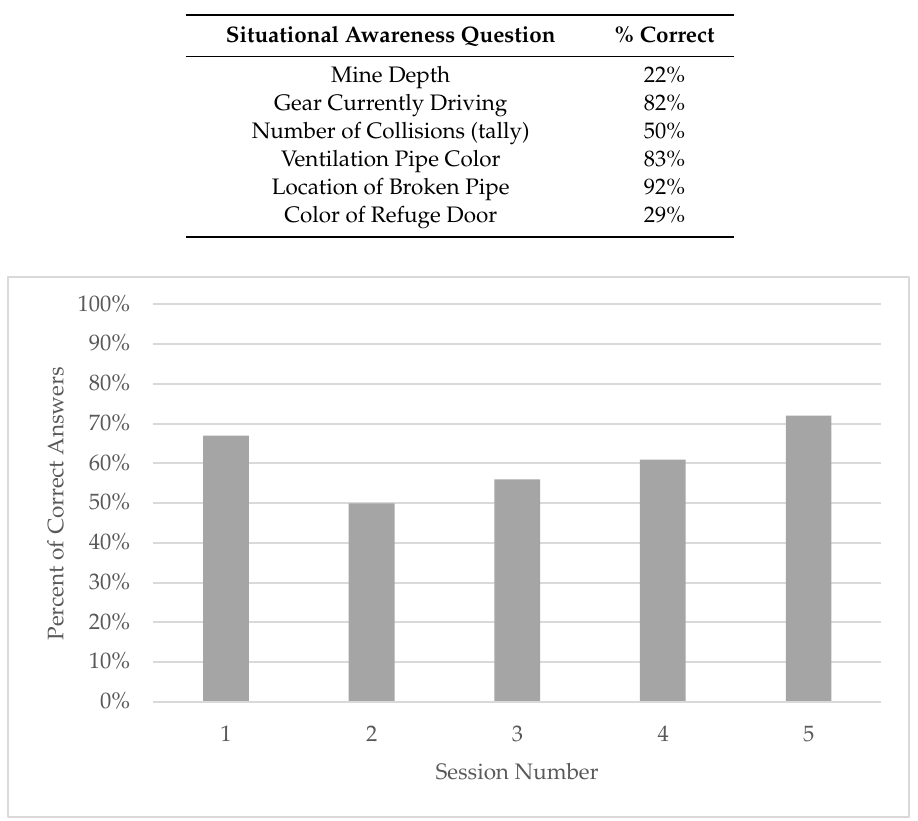
Table 2. Rate of correct answers by question type.